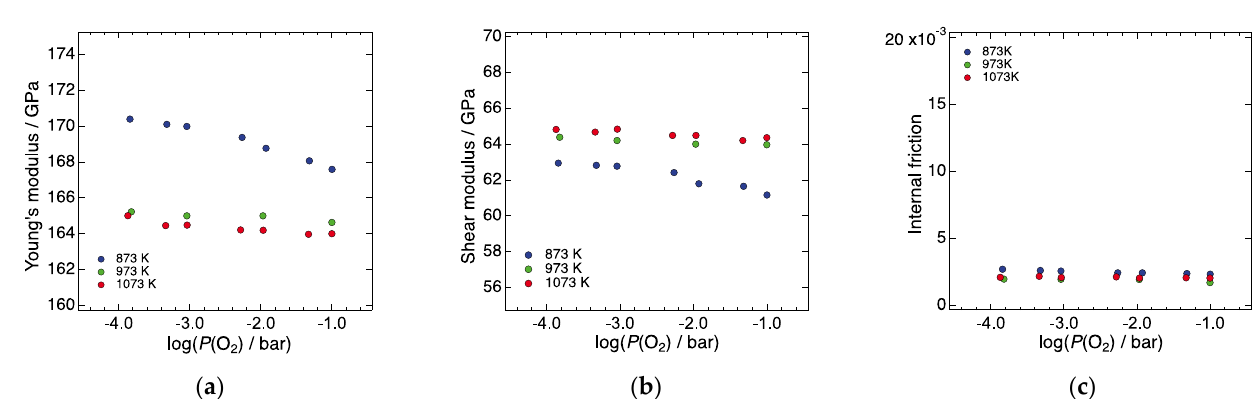
Figure 3. ( a ) Oxygen nonstoichiometry, ( b ) a -lattice constant, and ( c ) c -lattice constant of LN214 as a function of P (O 2 ) at 873, 973, and 1073 K in the P (O 2 ) range from 10 − 4 to 10 0 bar, which was taken from the literature [24,25].